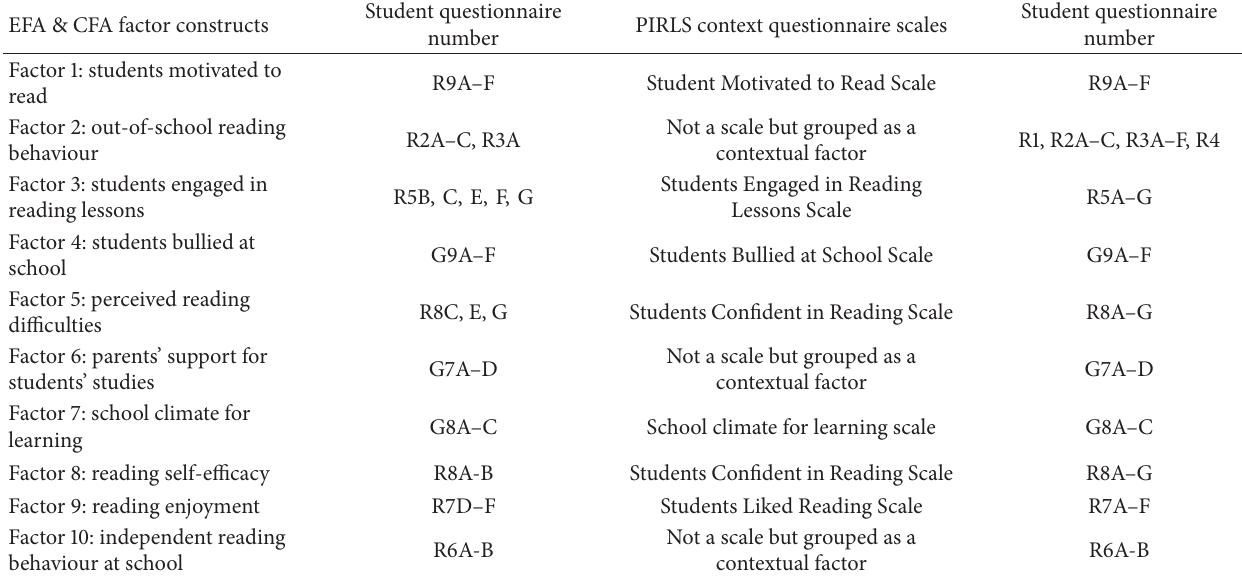
Table 5: Original context scale of the PIRLS 2011 and the factor structure in the PIRLS-SQCV